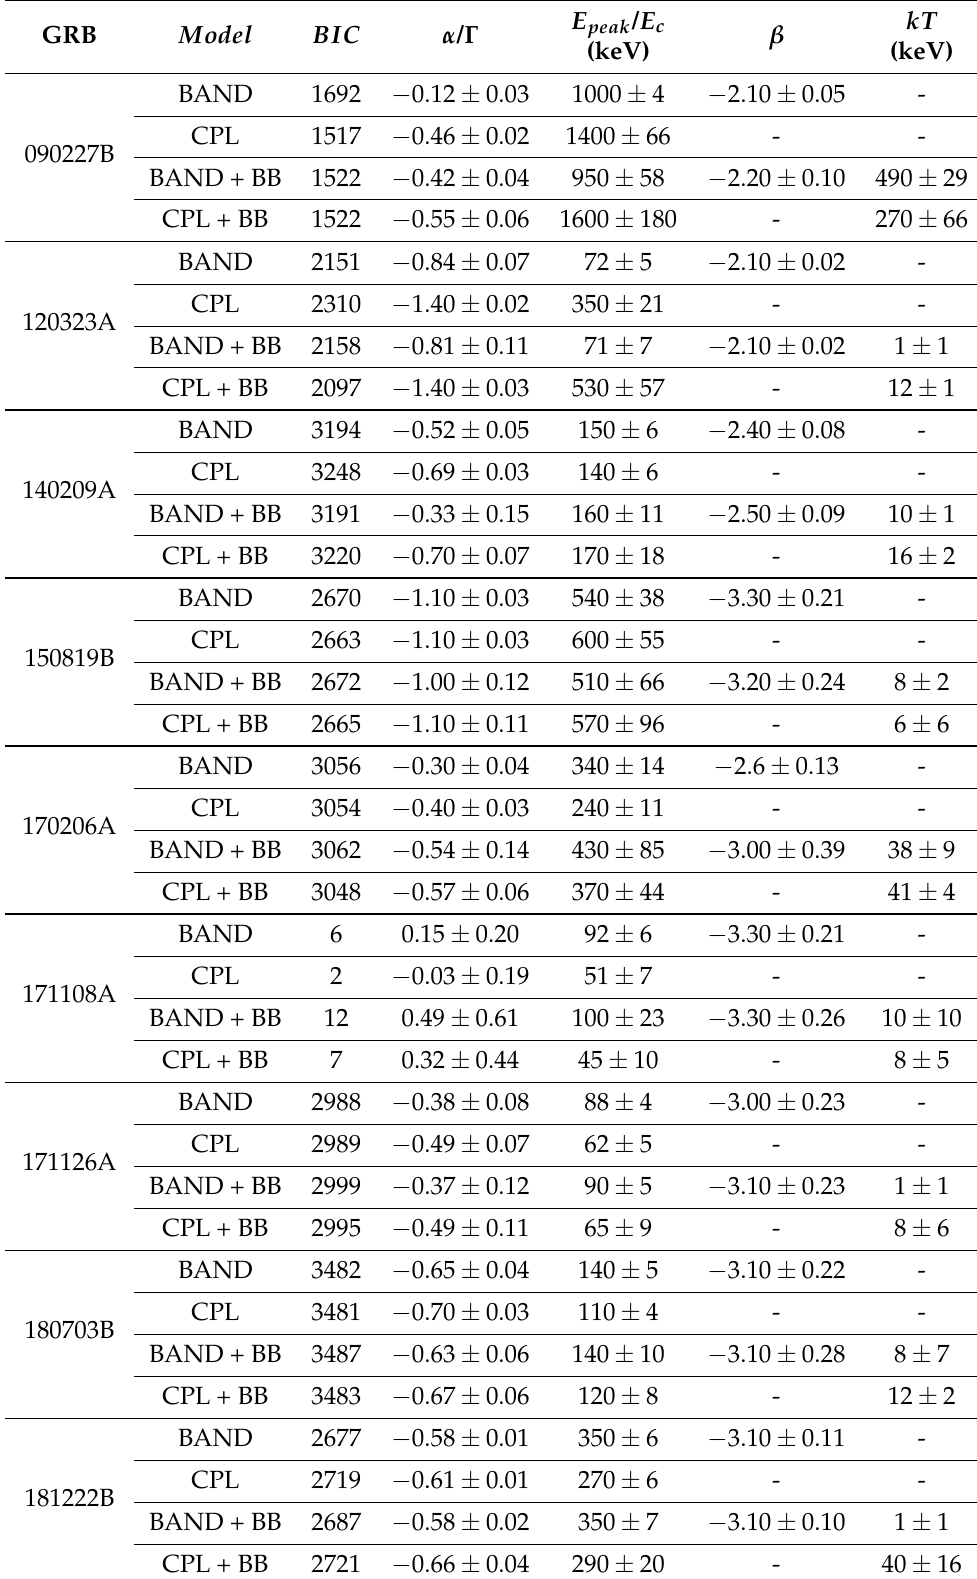
Table 3. Resultant parameters by the spectral